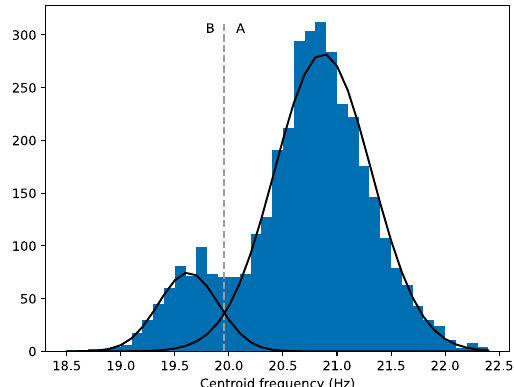
Figure 5. Histogram of the center frequencies of the detected pulses (post filtering). Black lines denote the fitted GMM, and the dotted line denotes the discrimination threshold between the two pulse